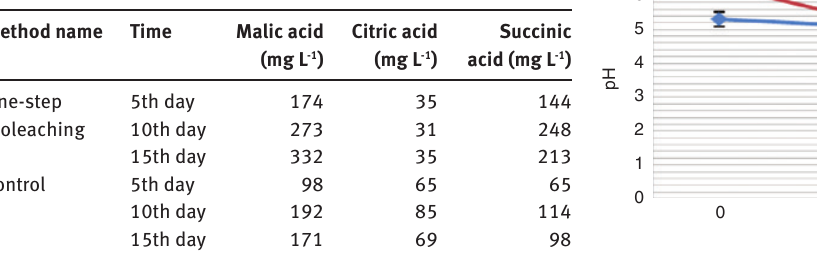
Table 3: Organic acids produced by A. flavus (F3) during different bioleaching processes.